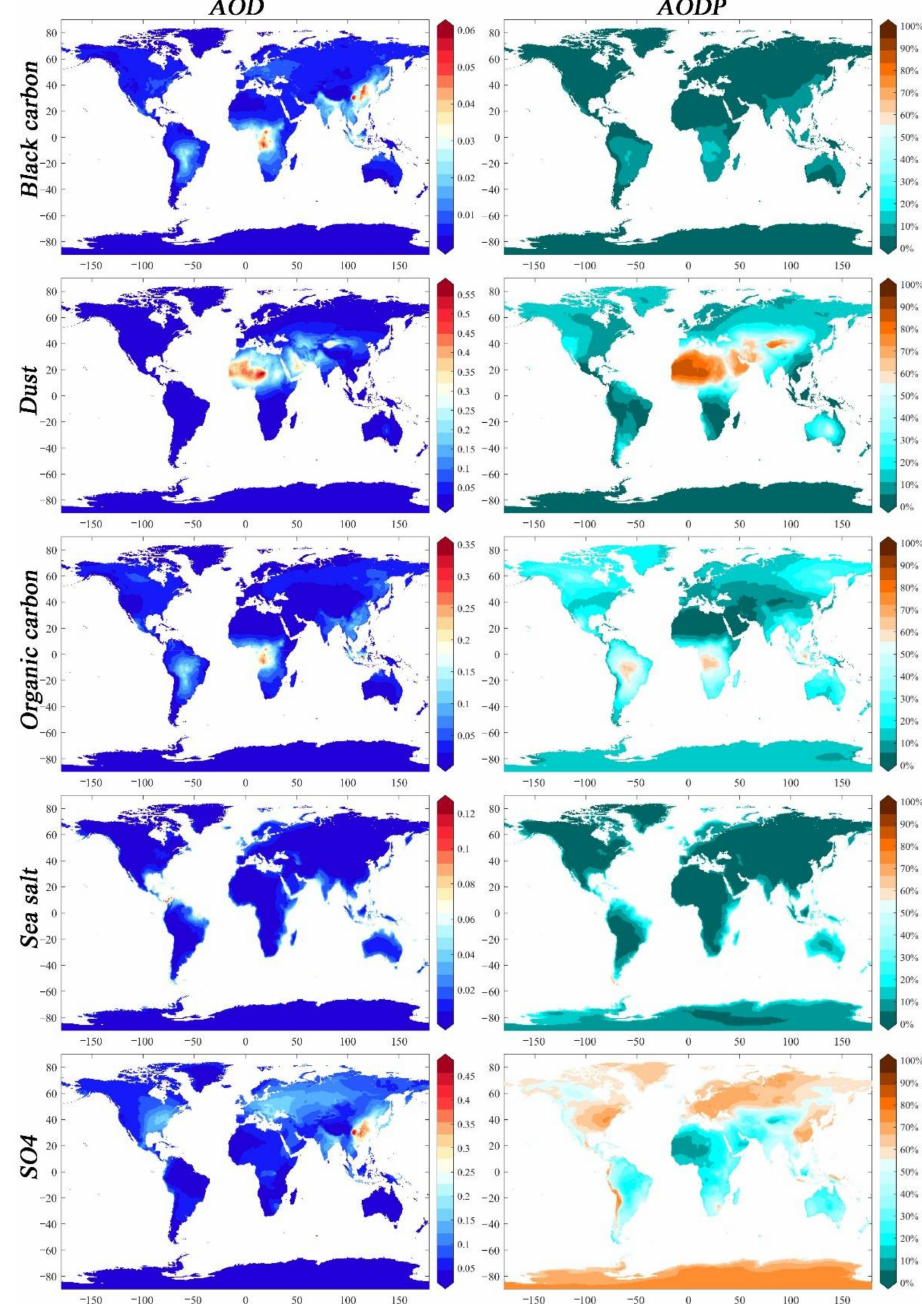
Figure 8. The spatial distributions of AOD and AODP values for different types of aerosols. The subfig- ures on the left indicate the AOD values, while the subfigures on the right indicate the AODP